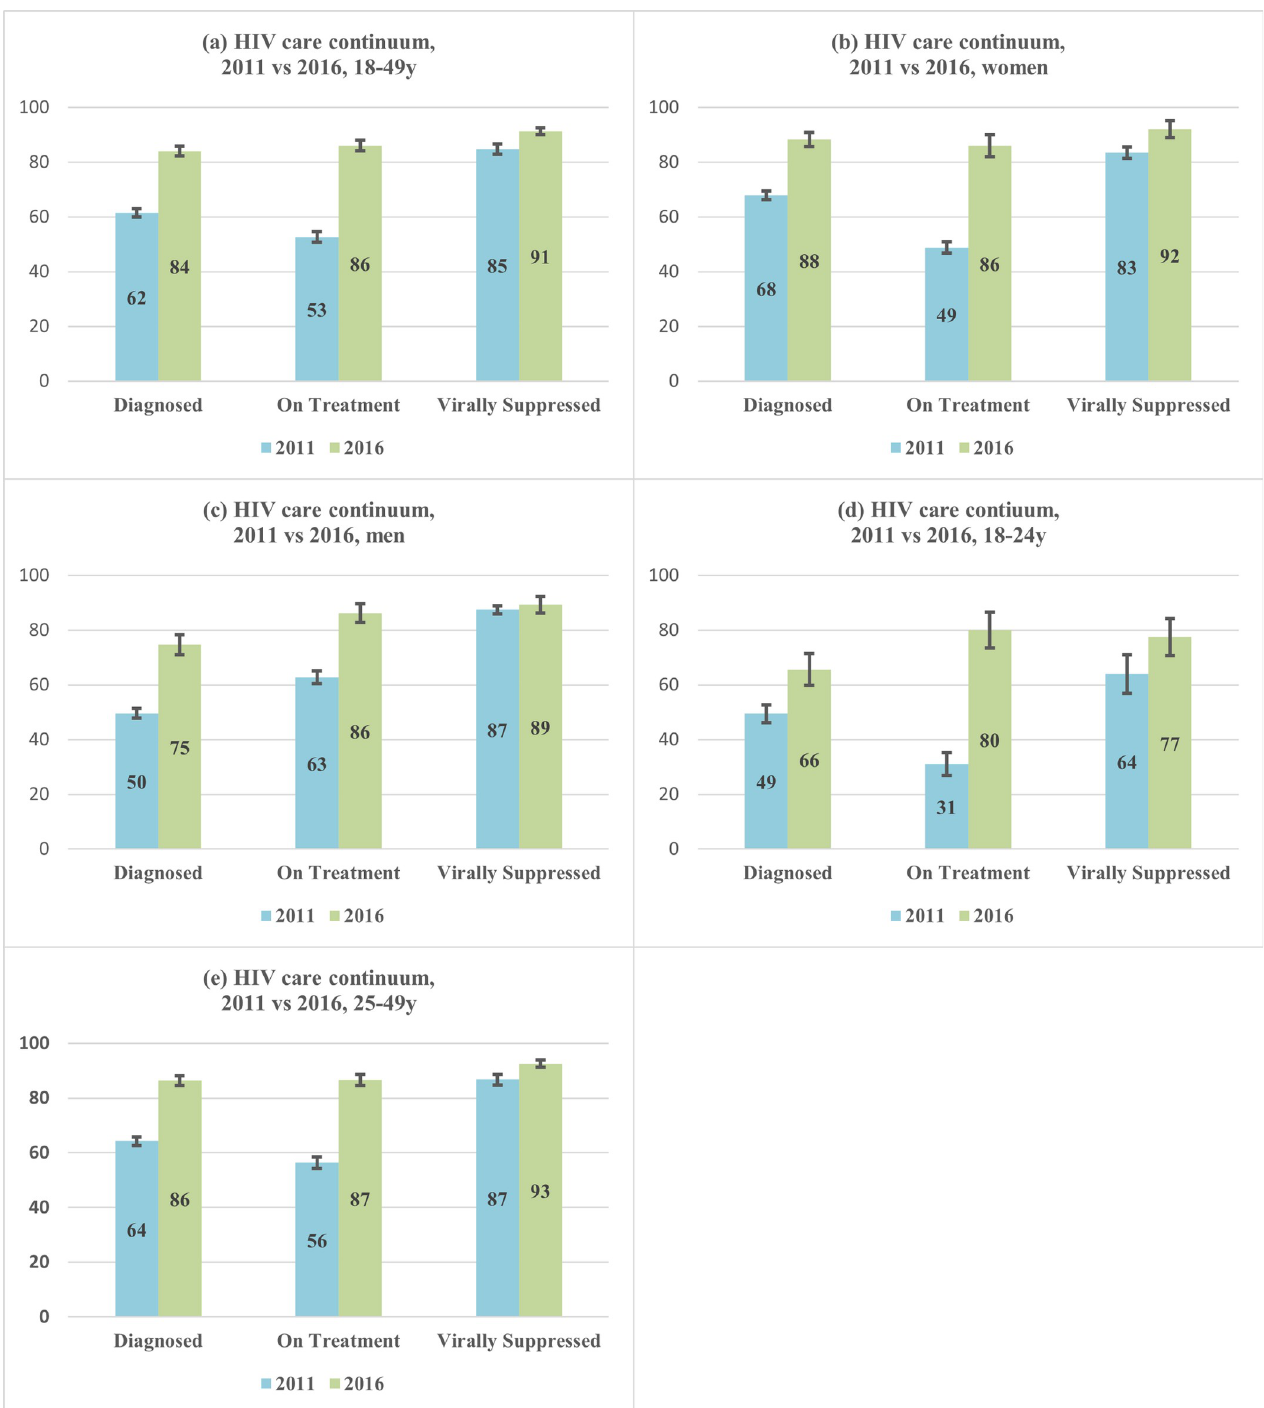
Fig 1. HIV care continuum (conditional proportions) � by age and by sex in 2011 and 2016. � Diagnosed was defined as self-reporting HIV-positive. Among those diagnosed, on treatment was defined as self-reporting current use of ART. Among those on treatment, virally suppressed was defined as viral load < 1000